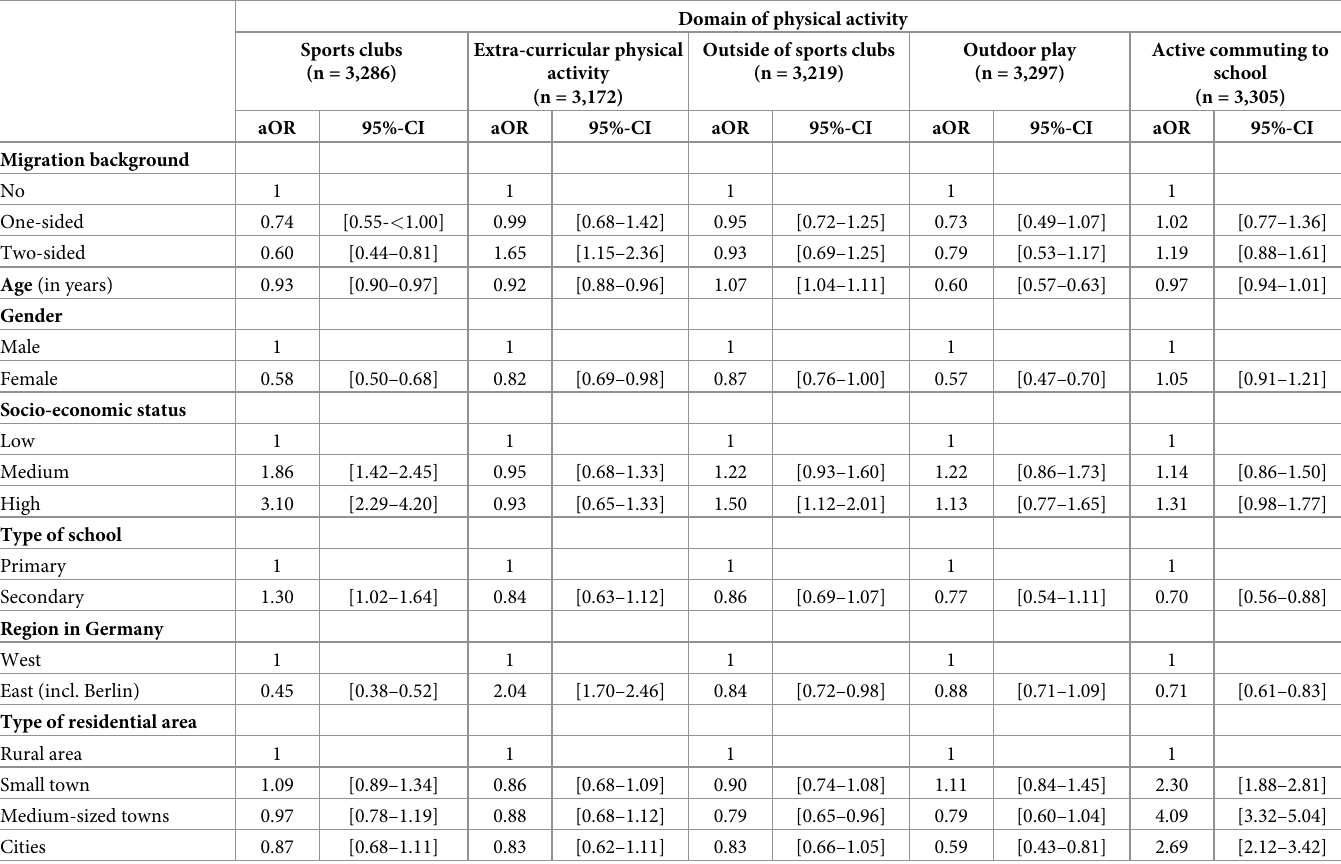
Table 2. Results of the multivariable logistic regression analysis of five domains of physical activity (adjusted odds ratios [aOR] and 95%-confidence intervals [95%-CI]; data from the Motorik-Module Study [MoMo] Study; no interaction effects